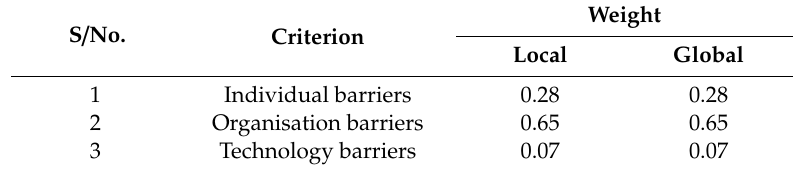
Table A1. Criteria weights by aggregate of all evaluators for main classes of probable causes. S / No.